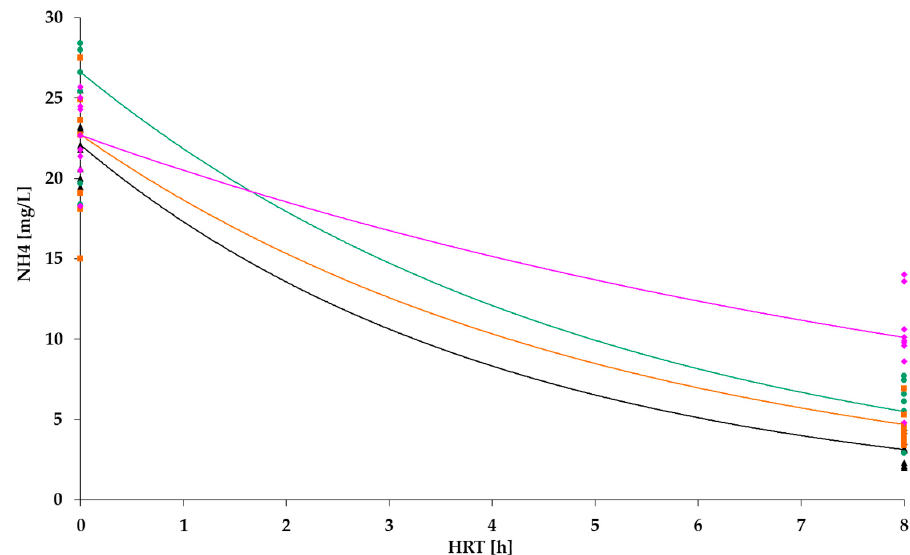
Figure 15. Ammonium removal dynamics if: floating carrier is PS (10% of reactor volume (black)); floating carrier is PV (20% of tank volume (green)); floating carrier is BB (20% of tank volume (orange)); no carrier in the reactor (magenta).